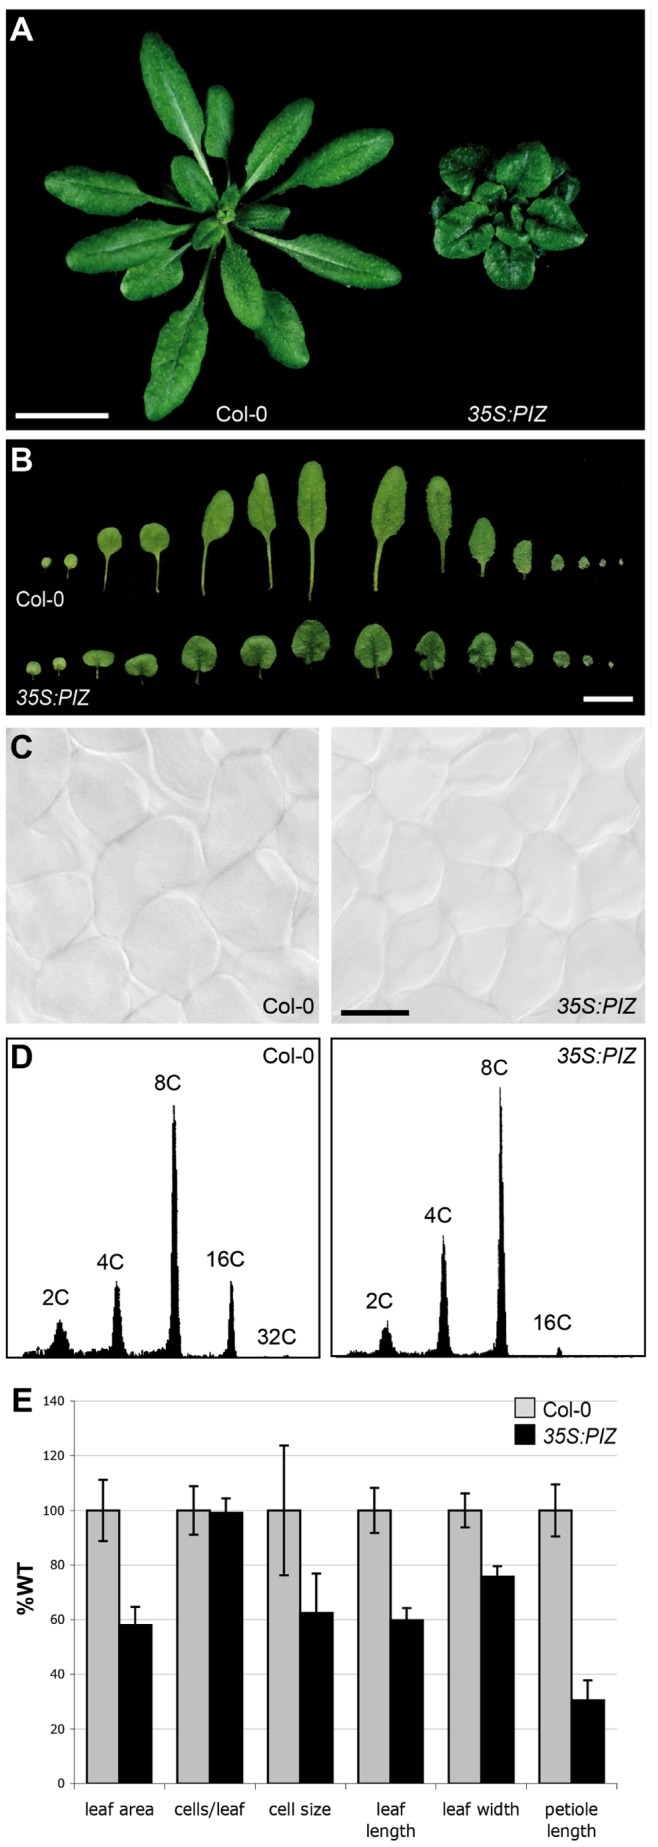
Overexpression of PIZ causes severe dwarf phenotypes.(A) 32-day-old wild-type (Col-0) and 35S:PIZ seedlings. (B) Leaf size of 32-day-old Col-0 and 35S:PIZ seedlings. (C) Light microscopic images of leaf mesophyll cells. (D) Flow cytometry analysis of first and second leaves from 17-day-old Col-0 and 35S:PIZ seedlings. (E) Leaf and cell size of 21-day-old 35S:PIZ seedlings. Values are shown relative to Col-0 and error bars represent ±SD of the means. n = 20 for leaves, n = 300 for cell size and n = 4 for cell number (p<0.0001, student’s t-test). Scale bars represent 1 cm in (A, B) and 50 µm in (C).